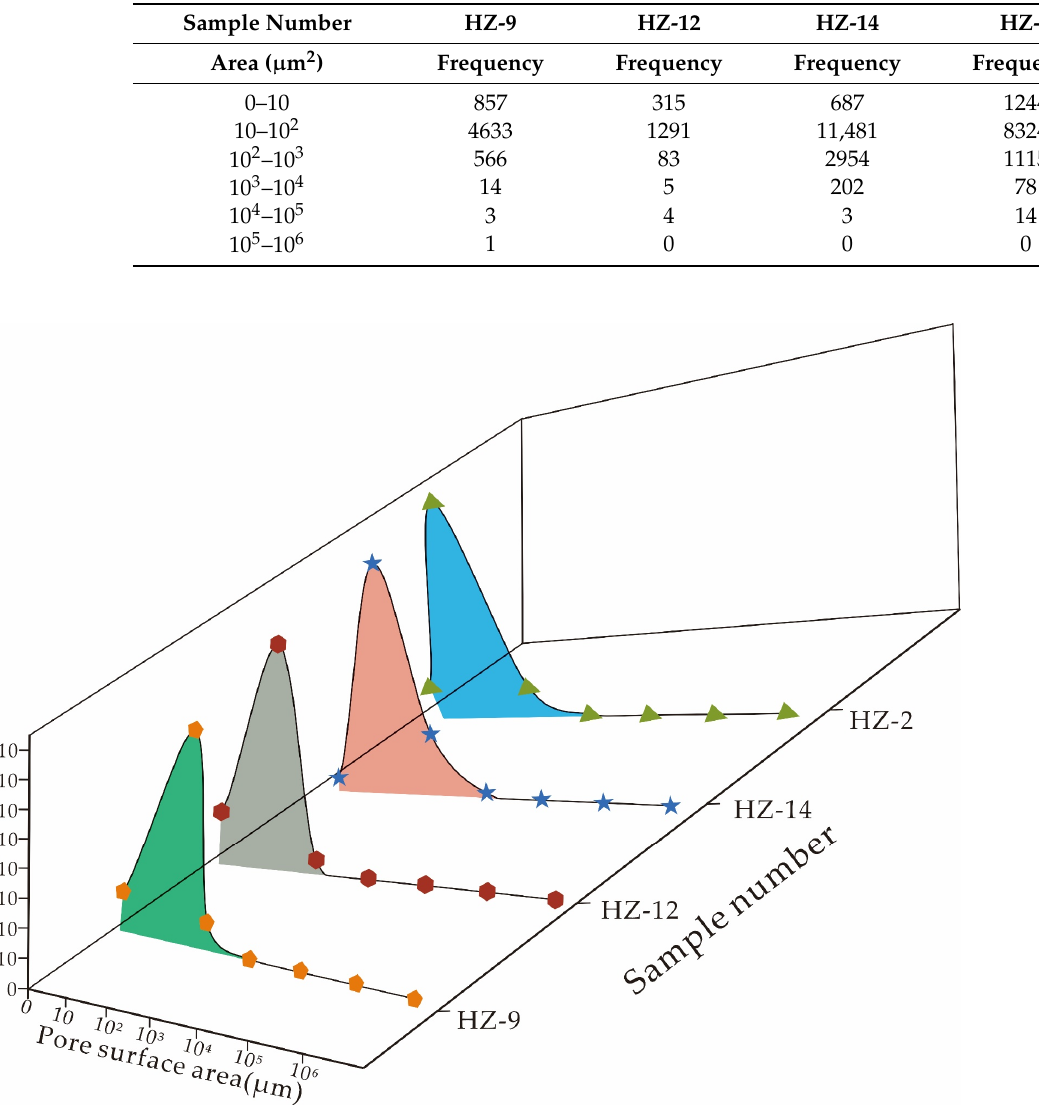
Figure 10. Pore surface area ratio of the carbonate rock samples in the Huize lead–zinc deposit.